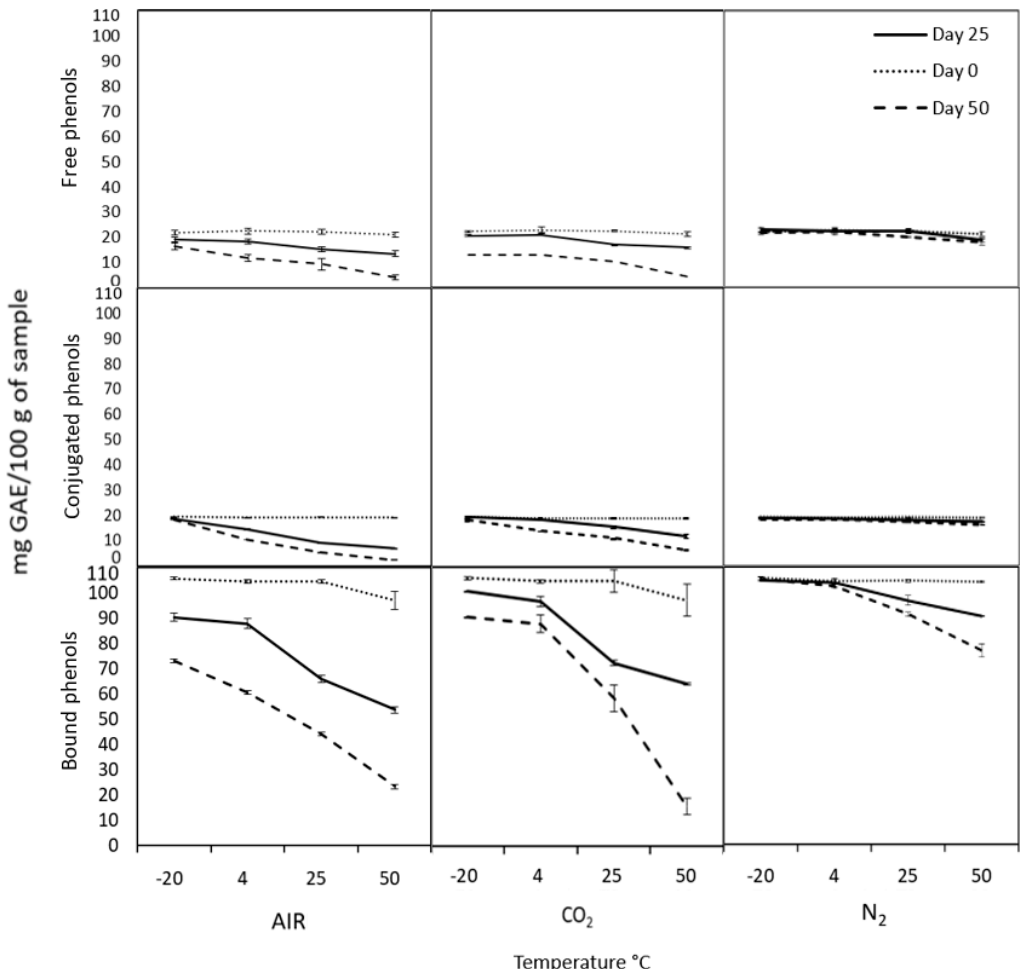
Figure 4. Quantification of total phenols of free, conjugated and bound phenols under different storage conditions. Control was air treatment. Table 3. Proximal chemical analysis in cooked chickpea at − 20 °C in N 2 atmosphere at day 0 and day 50.